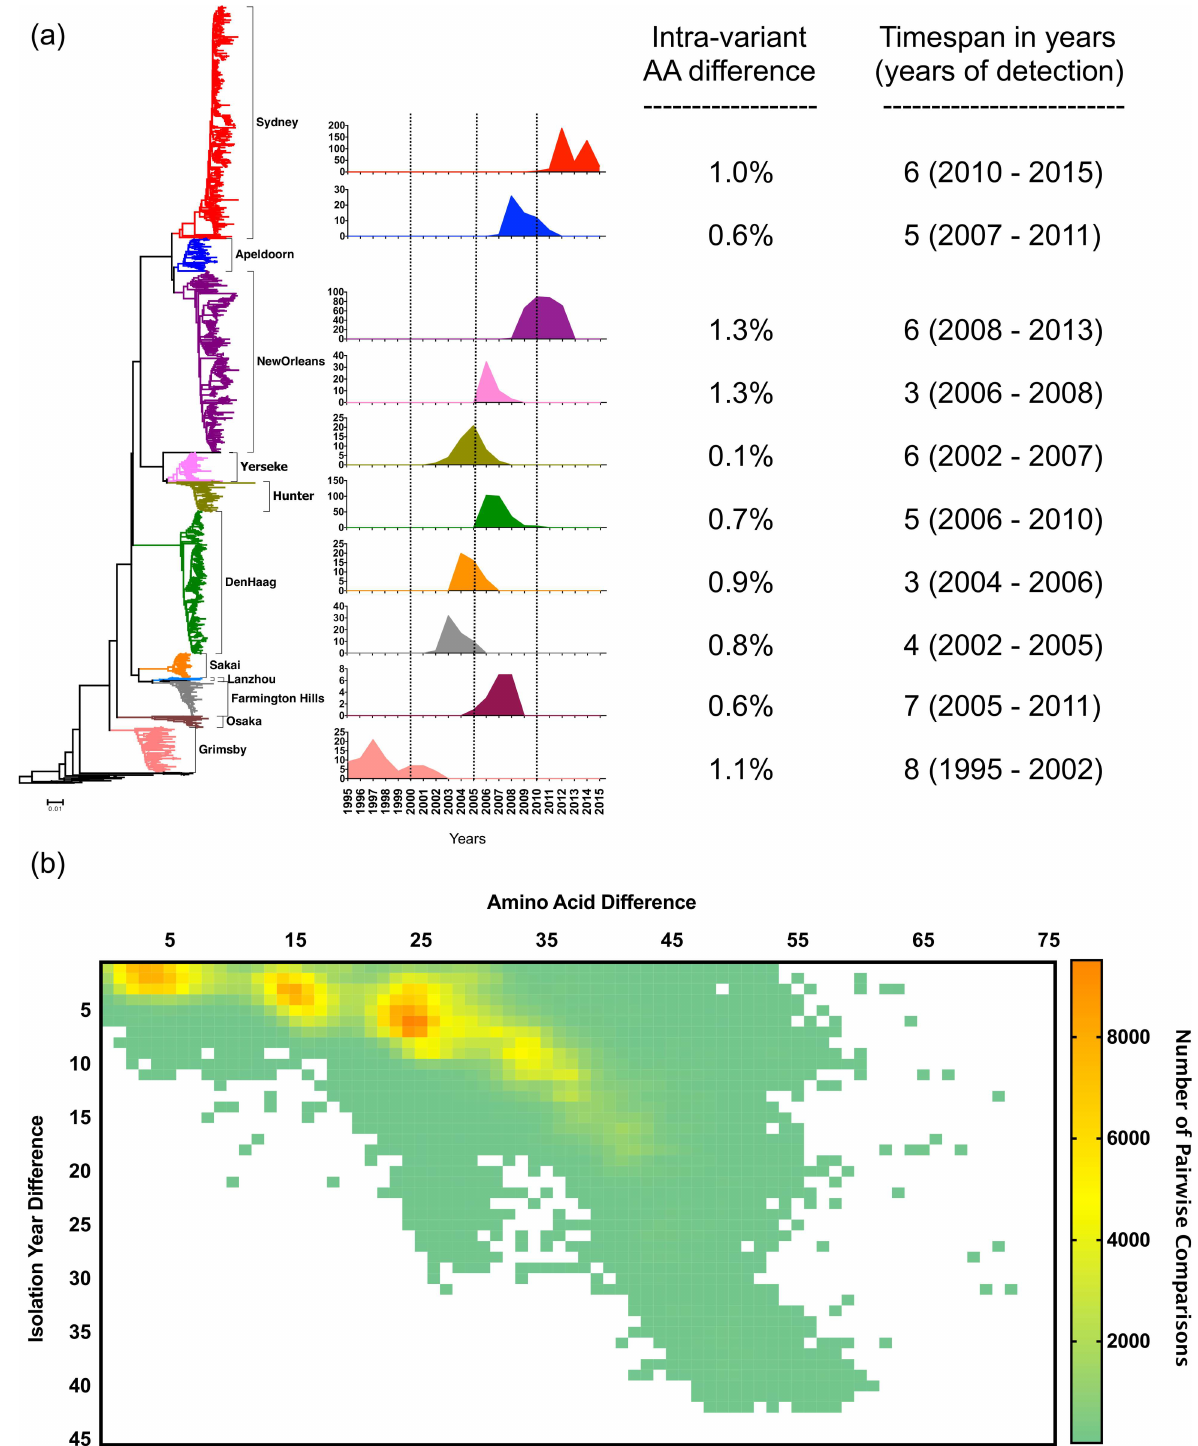
Fig 1. Diversity and evolutionary pattern of GII.4 noroviruses. (a) Phylogenetictree showingthe presenceof multiple variants within the GII.4 genotype. Each variant is identifiedby a different color and name. Sequencesfrom each variant were collectedfrom a period of 3–8 years (mean: 5.3 years) until replacedby a novel variant. Tree was constructed using nt sequencesencoding the VP1 and Kimura 2-parameter and Neighbor-Joining method as implemented in MEGA v6. Plots indicate the numberof sequencescollectedeach year from ten major GII.4 variants. (b) Diversity plot showingthe accumulationof aa mutations over time in the VP1 from GII.4 viruses.